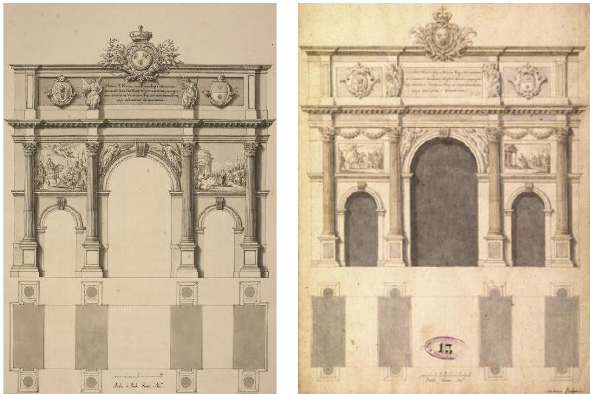
Figure 2a. A. Visentini, Restituzione ideale dell’arco trionfale per l’ingresso di Enrico III a Venezia, 1756, British Museum, London: elevation and plan. Figure 2b. A. Visentini, Triumphal Arch built by Palladio (In Celebration of the Visit of Henry III of France to Venice, 1574), XVIII sec, Kansas, Nelson-Atkins Museum: elevation and plan.